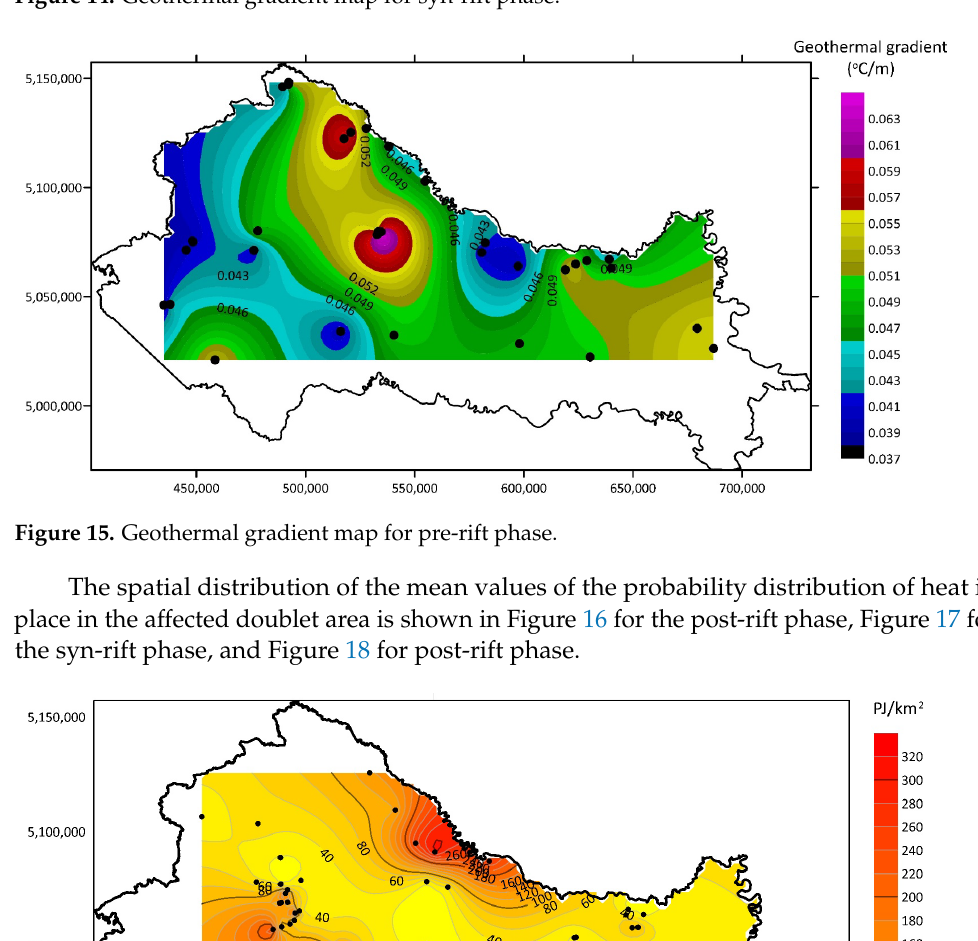
Figure 14. Geothermal gradient map for syn-rift phase.